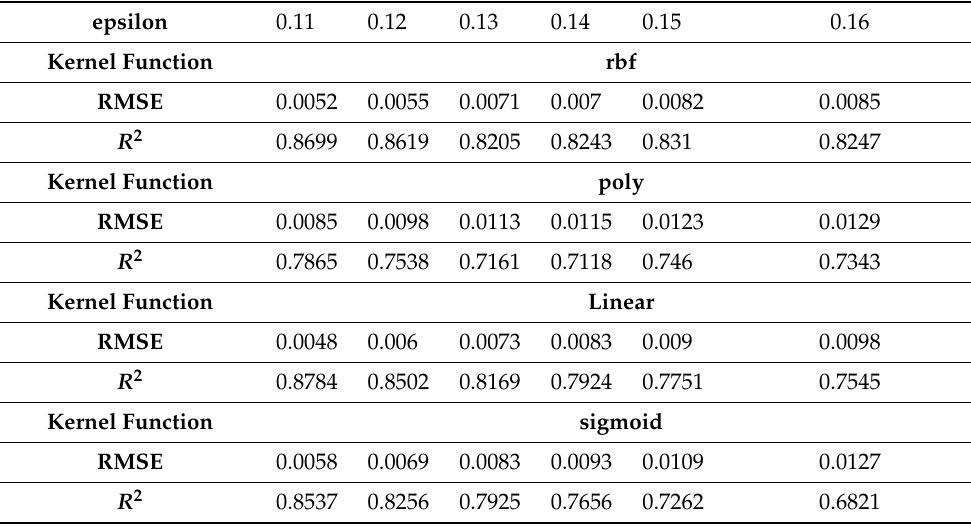
Table 3. Kernel function comparison (100%